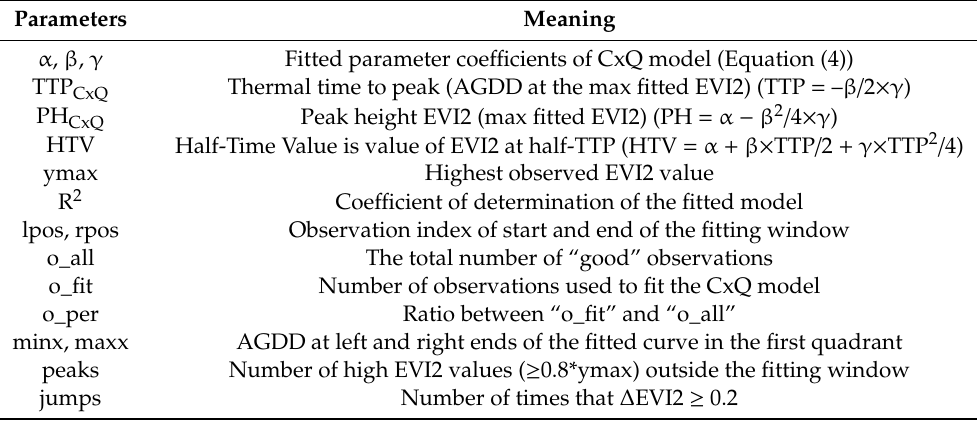
Table 1. Variables derived from the Convex Quadratic